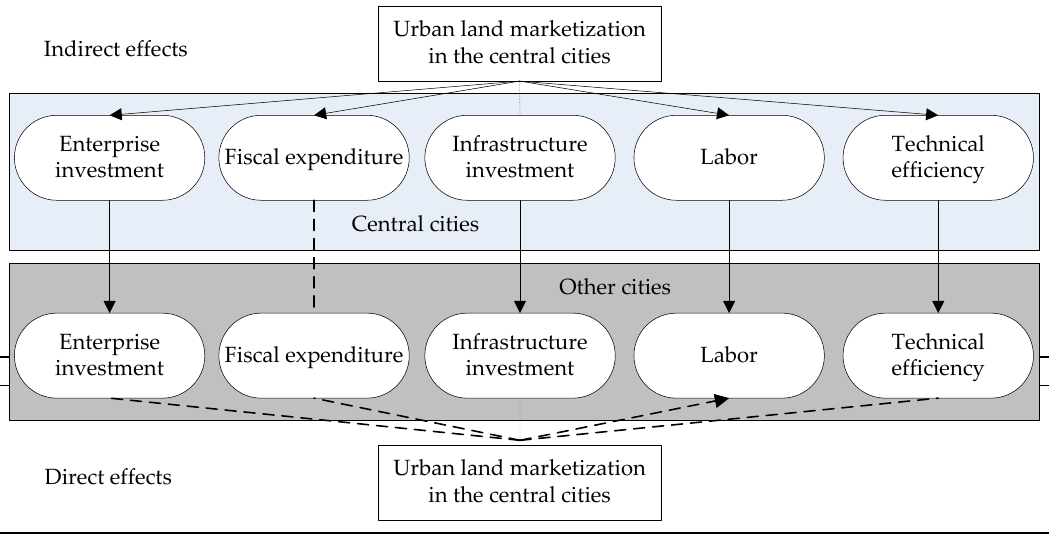
Figure 7. The impacts of urban land marketization on the production factors in urban agglomera-